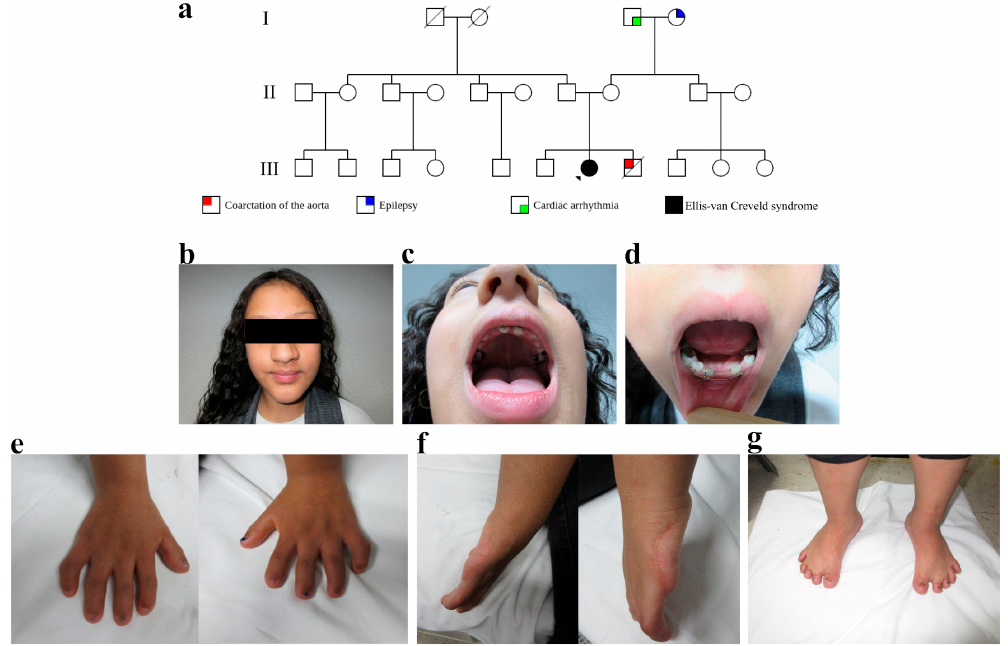
Figure 1. Clinical features of a patient with Ellis–van Creveld syndrome. ( a ) Pedigree of a Mexican family with compound heterozygote EVC2 variants. The square denotes a male family member; the circle presents a female family member; the slashed symbol indicates a deceased family member; the fully shaded symbol shows the patient with EvCS (III:7); III:8 shows a patient with coarctation of the aorta. ( b ) Central and large nose with a regular nose bridge and a broad-based bulbous tip. ( c , d ) Multiple oral frenula, dysplastic teeth, and hypodontia; absence of two maxillary incisors and the bilateral presence of the first premolar and first molar, mandibular anodontia with bilateral presence of canines, and the first premolar and first molar. ( e ) Wide hands with wide fingers, brachydactyly, and dysplastic nails. ( f ) Bilateral postaxial polydactyly resection scar. ( g ) genu valgum and short toes with nail dysplasia. 2.1.2. Case 2 The proband (pedigree III:11) was a 15-year-old female, born to an unaffected couple (Figure 2a). Physical examination revealed a height of 145 cm (below 5 centiles, according to the tables of Centers of Disease Control and Prevention), a normal nasal bridge, a straight nasal septum, a bulbous nasal tip, a wide columella, and a short philtrum (Figure 2b). Additionally, an oral cavity with an intact palate, a central uvula, and hypodontia were found (Figure 2c,d). Pectus carinatum and rhythmic heart sounds without aggregated sounds were revealed; her electrocardiogram and echocardiogram were normal. In the upper limbs, she presented brachydactyly, bilateral dysplastic thumb nails, wide fingers, a scar in the ulnar region of both hands, and cubitus valgus (Figure 2e,f). In the lower limbs, there were dysplastic nails, bilateral increased space between the first and second toe, bilateral second long toe, and genu valgum (Figure 2g). All relatives were unaffected with no similar features; however, the patient’s parents had a previous miscarriage (pedigree III:10). Moreover, in the first mother’s relationship, there was a history of two miscarriages (pedigree III:13 and III:14).